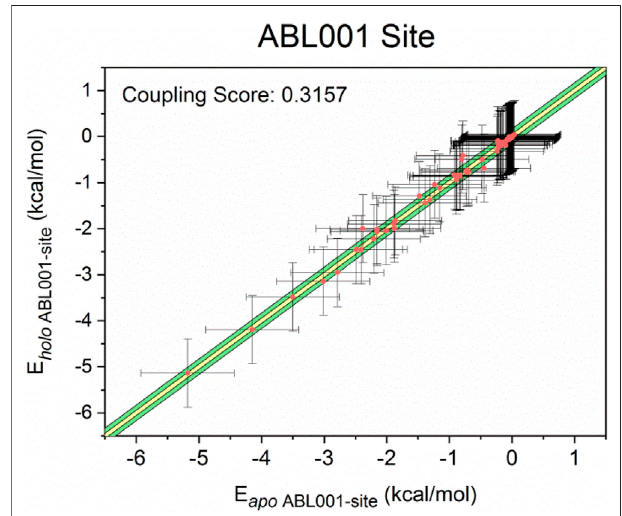
the co-binding of inhibitors signi fi cantly remodeled the topology of communities, possibly accounting for their inhibition.